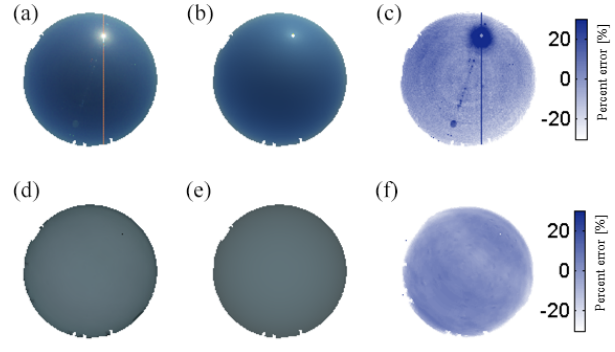
Figure 5. (a) Clear-sky USI image for 26 March 2013, 15:00:00UTC; (b) synthetic image from SHDOM for τ c of 0 and θ 0 of 60 ◦ ; (c) percent error in red channel radiance; (d) USI image for 5 May 2013, 14:08:00UTC; (e) synthetic image for θ 0 of 60 ◦ and τ c of 30; (f) percent error in red channel